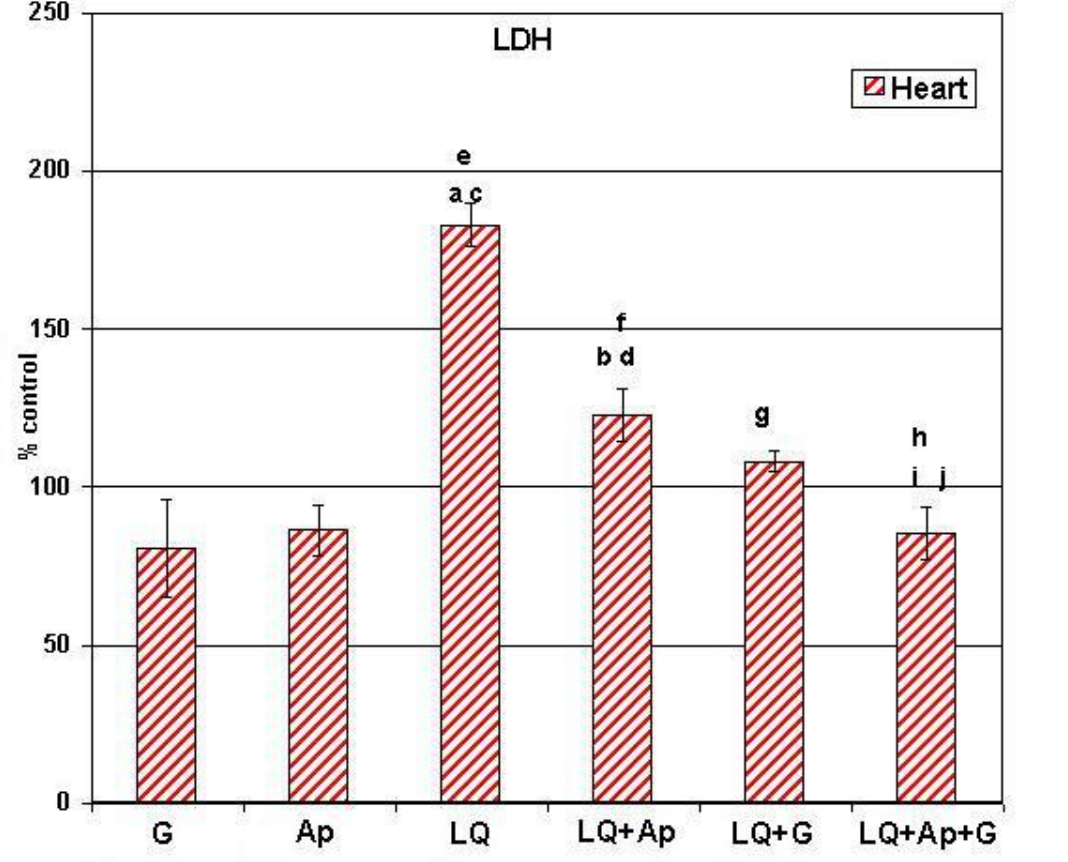
Figure 5: Effects of Leiurus quinquestriatus venom (LQ) alone or after pretreatment with Ginkgo biloba extract (G) and/or aprotinin (Ap) on lactate dehydrogenase activity (LDH) in the cytosolic fraction of the rat heart